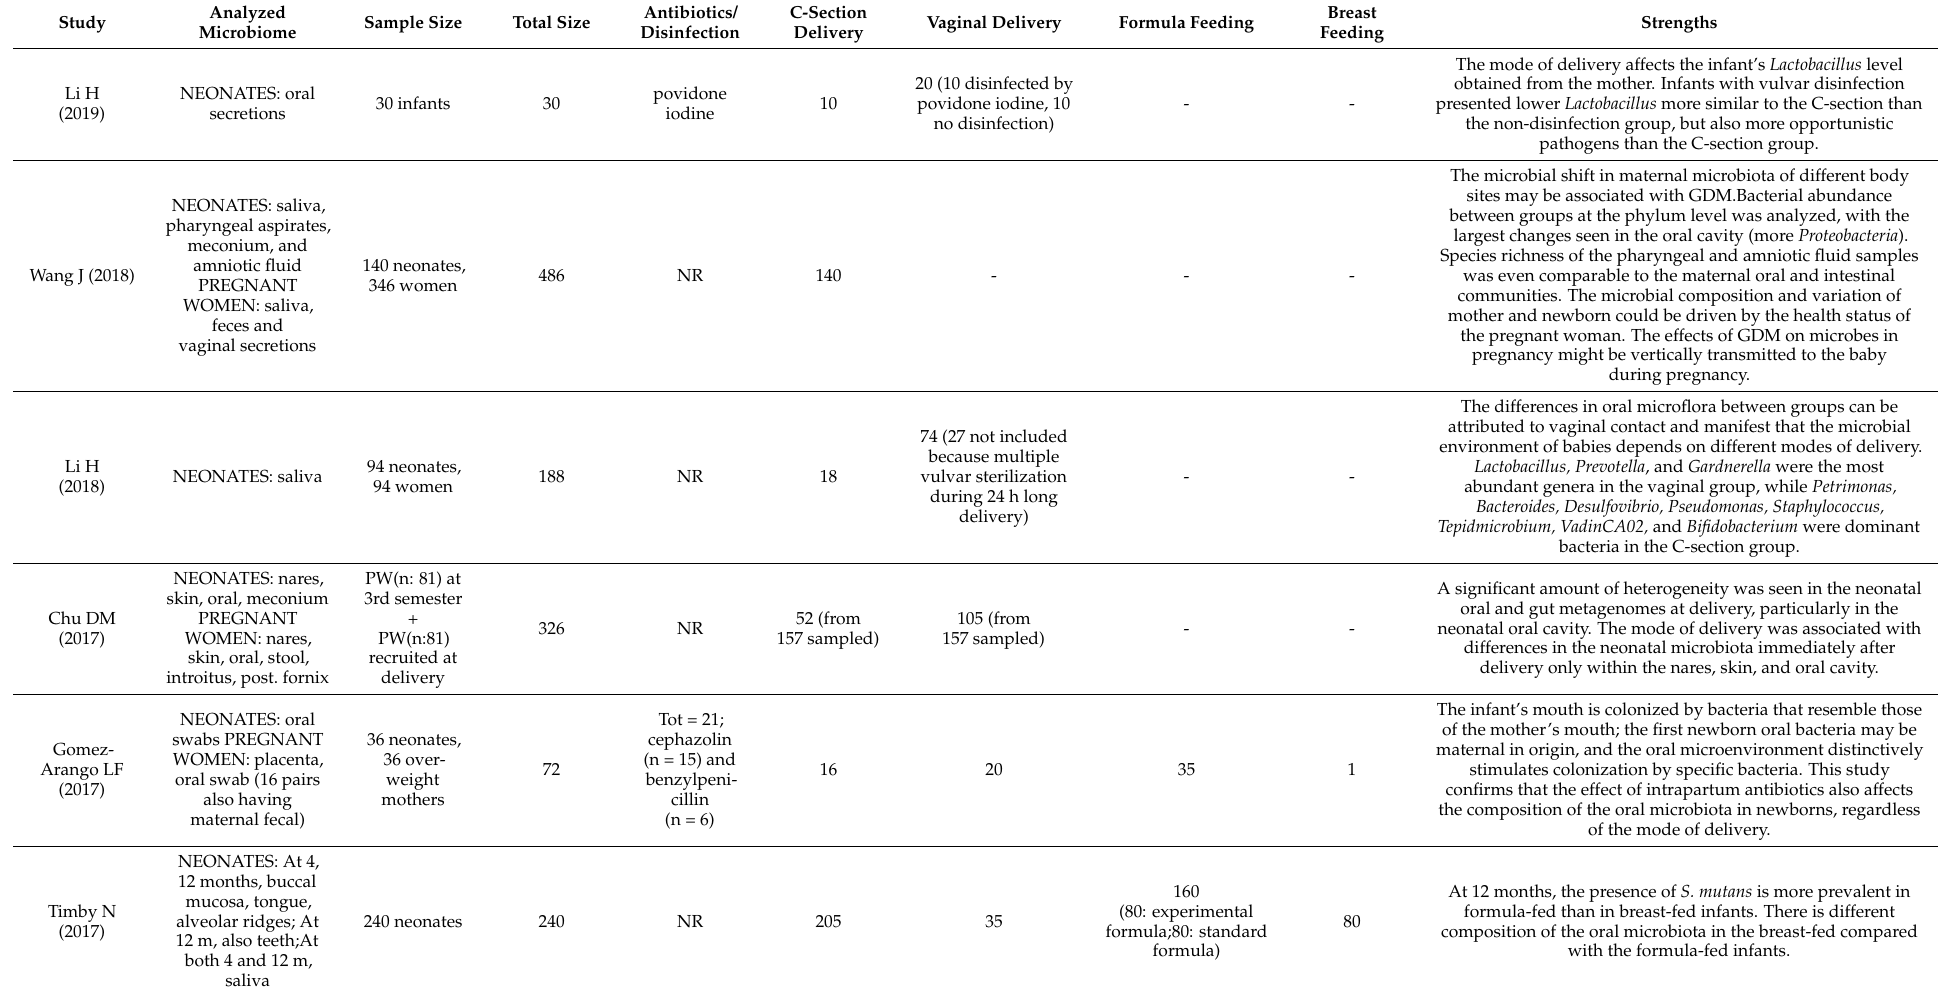
Table 1. Characteristics of each of the 11 included studies.